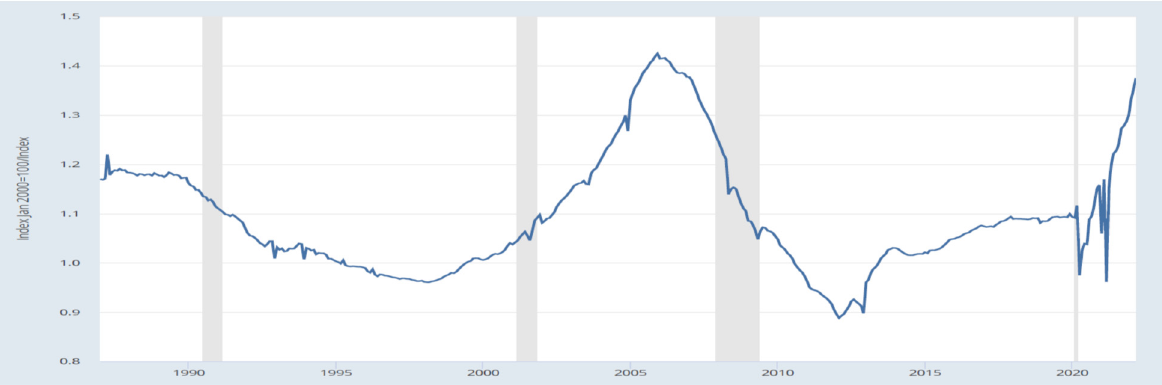
Figure 18. Ratio of S&P Case Shiller Price Index to Per Capita Disposable Income. Source: S&P Dow Jones; Bureau of Economic Analysis.